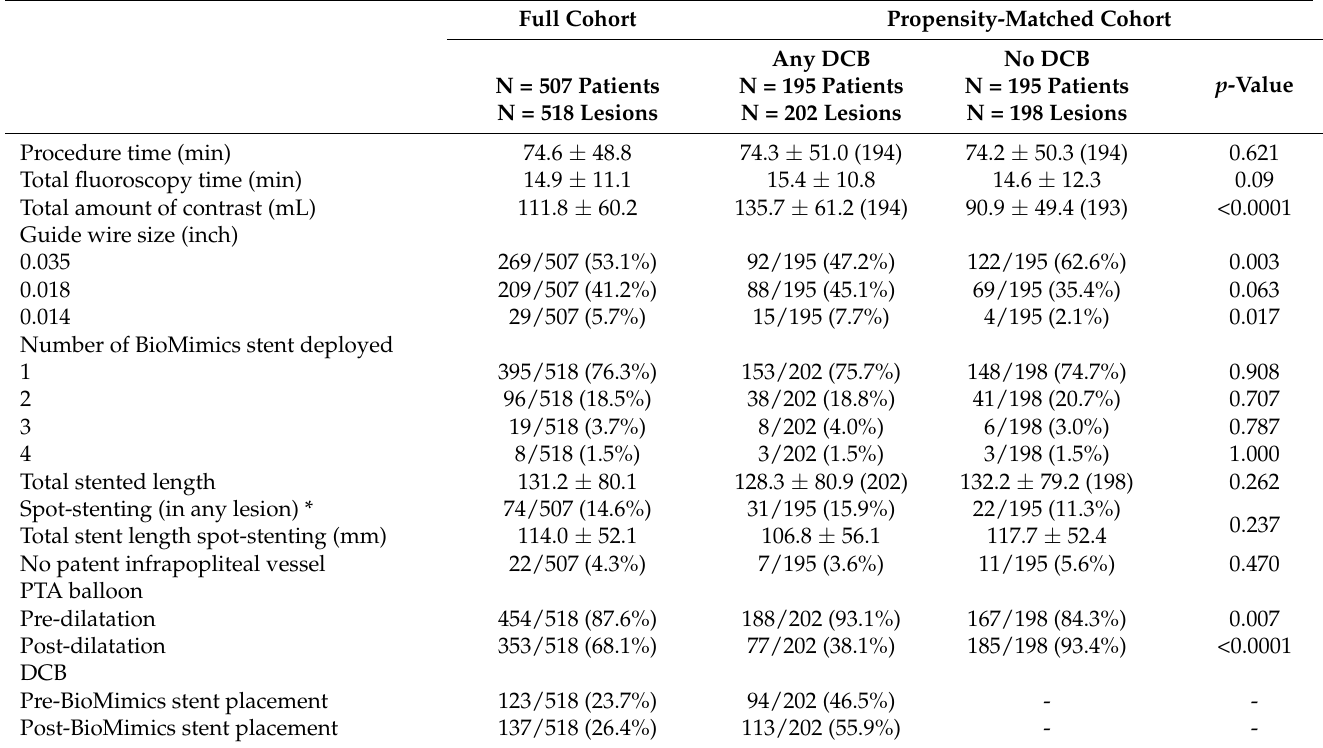
Table 3. Procedural